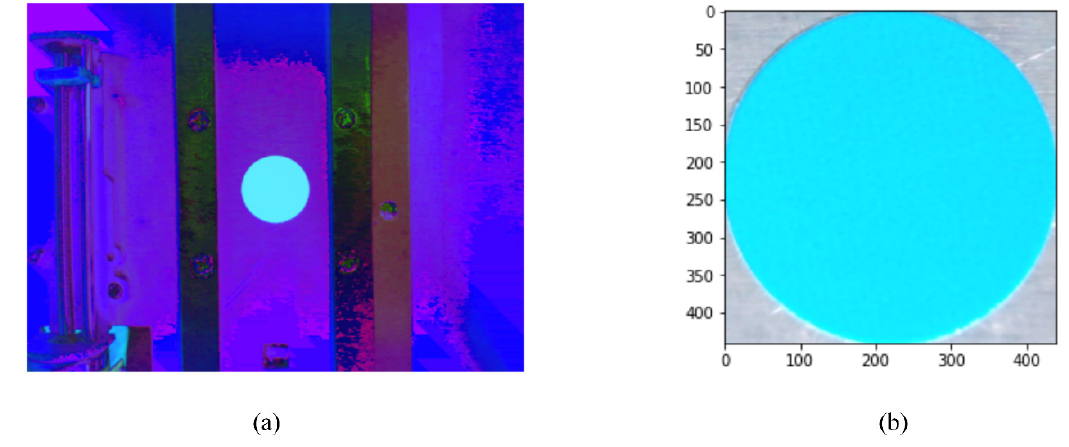
Figure 6. Images acquired in the motor precision testing fixture. ( a ) Image converted to HSV coordinate; ( b ) Image of the blue sticker in the bounding box.